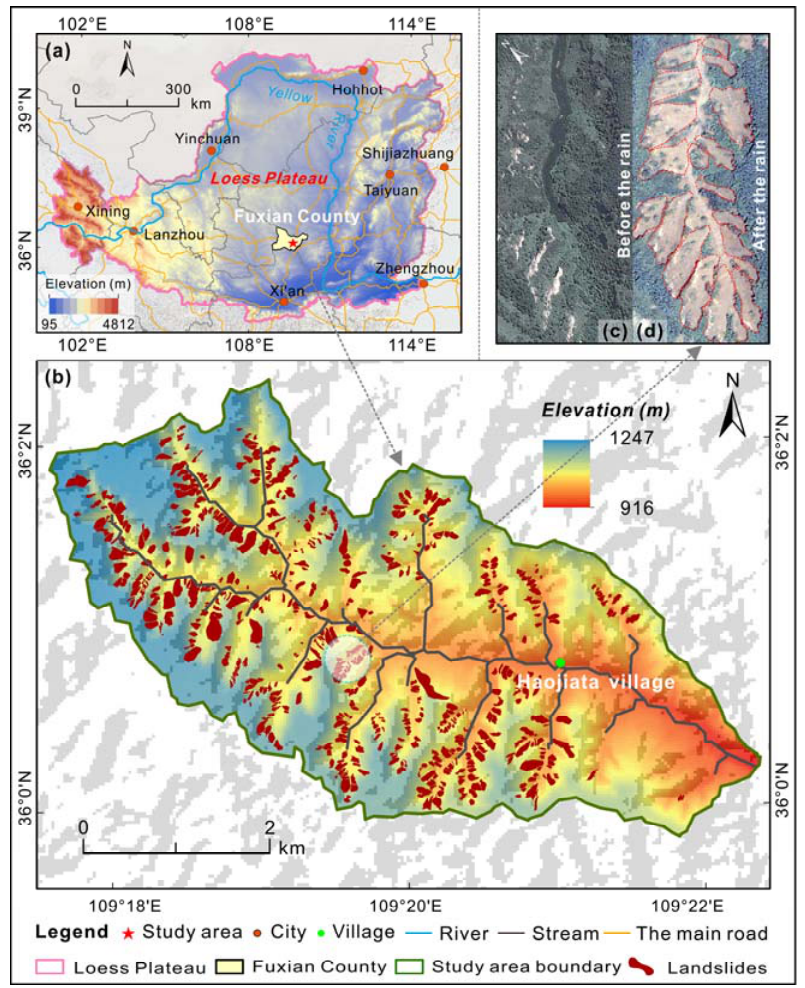
Figure 1. ( a ) Location of study area. ( b ) The digital elevation model (DEM) of the watershed and landslide interpretation (the grey base map represents the hillshade). ( c , d ) Satellite images acquired before and after the rainfall in July 2013, with clearly visible landslides scars.